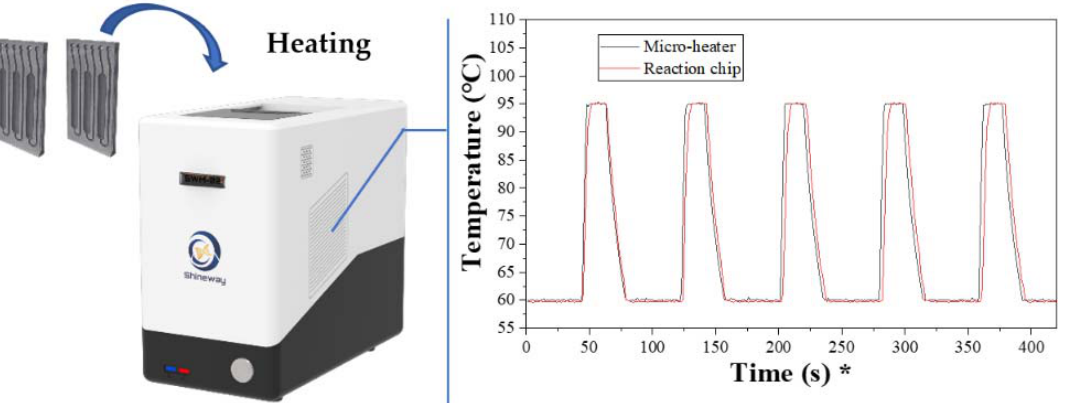
Figure 4. Schematic diagram of the heating process and temperature changes of the microheater and the aluminum chip in five randomly selected cycles during the real-time PCR process. * The first point in the randomly selected thermal cycles is defined as 0 s.